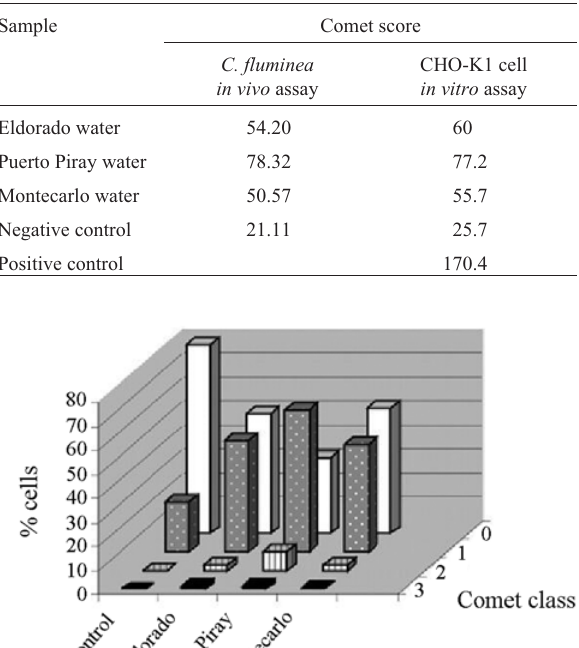
Table 1 - Comet cell damaged scores obtained for Corbicula fluminea hemolymph cells and Chinese hamster K1 (CHO-K1) cells. Scores were calculated by summing the number of cells in each class and then multi- plying by the class value (0 to 3). The negative control was well water for C. fluminea and phosphate buffered saline for the CHO-K1 cells. The pos-